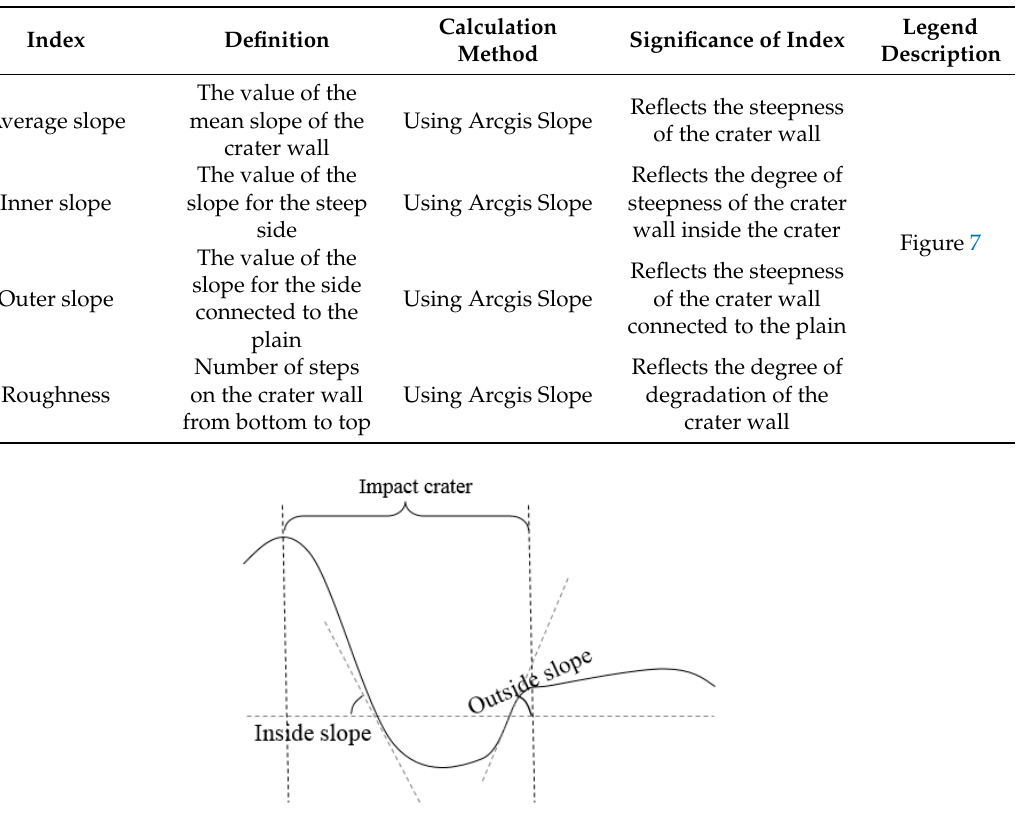
Figure 6. The inner crater wall of Copernicus (from NASA, [52]). Table 3. Indices for description of the crater wall.